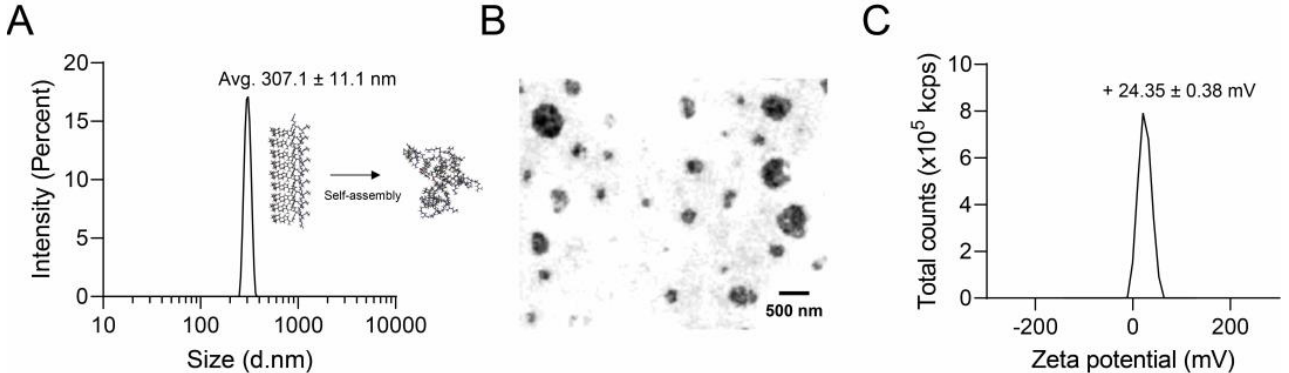
Figure 3. Nano-characterization of RR–BA molecules. ( A ) RR–BA nanoparticles in aqueous condi- tions with a Z-average size of 283.6 nm, polydispersity index (PDI) of 0.1424, and size (intensity) of 307.1 ± 11.1 nm. ( B ) Transmission electron microscopy (TEM) image of RR–BA nanoparticles. ( C ) Zeta potential distribution of RR–BA, showing a positively charged surface.